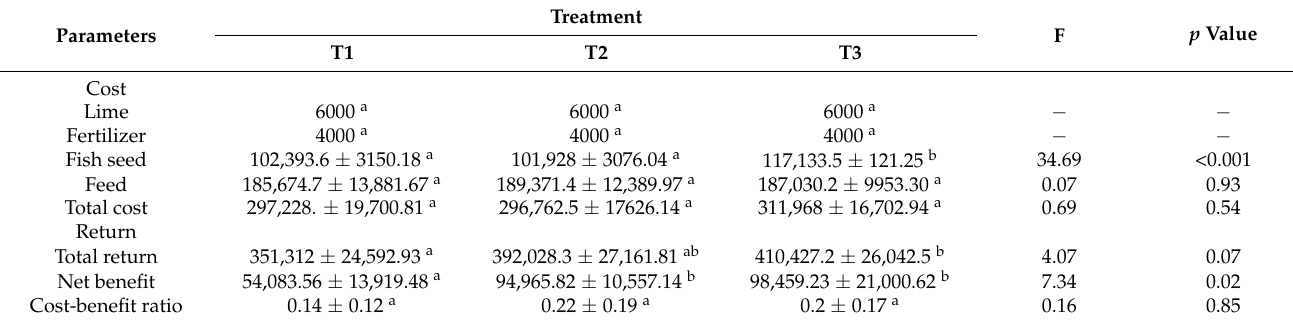
Table 4. Economics of different